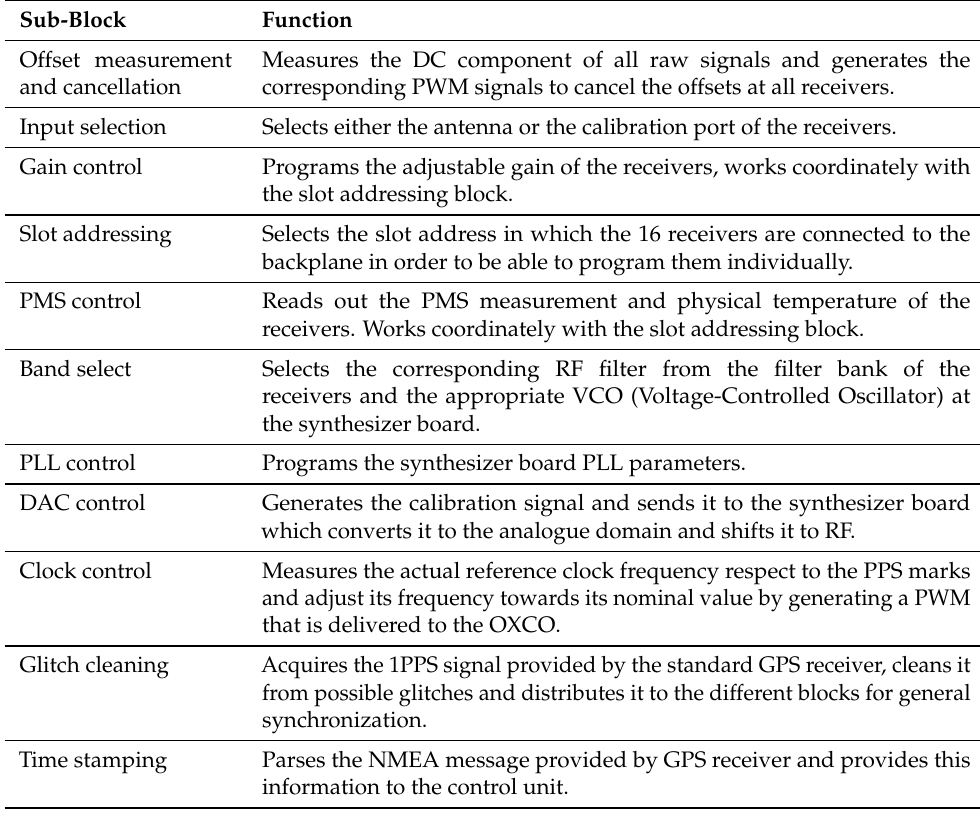
Table 1. Function of the different sub-blocks of the Control